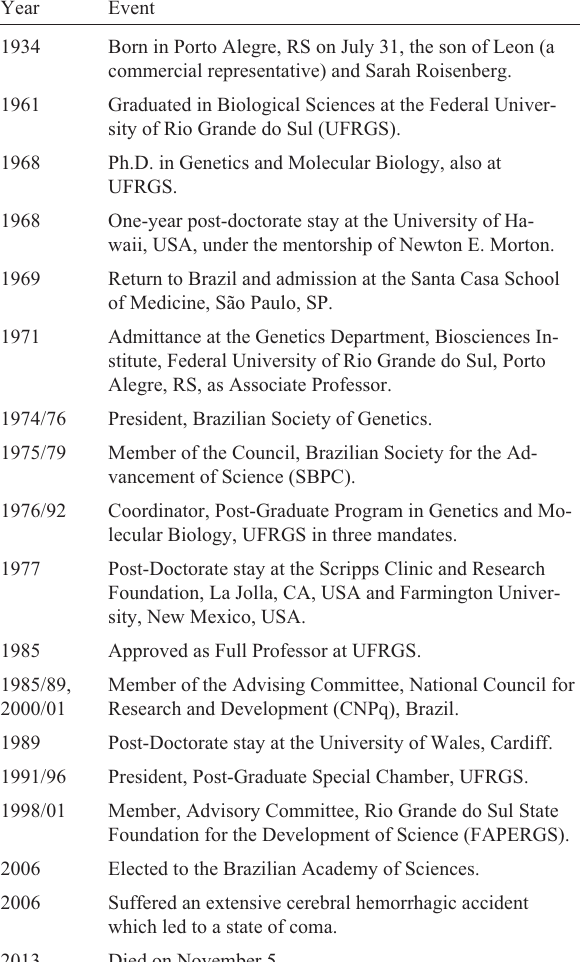
Table 1 - Main events related to the life of Israel